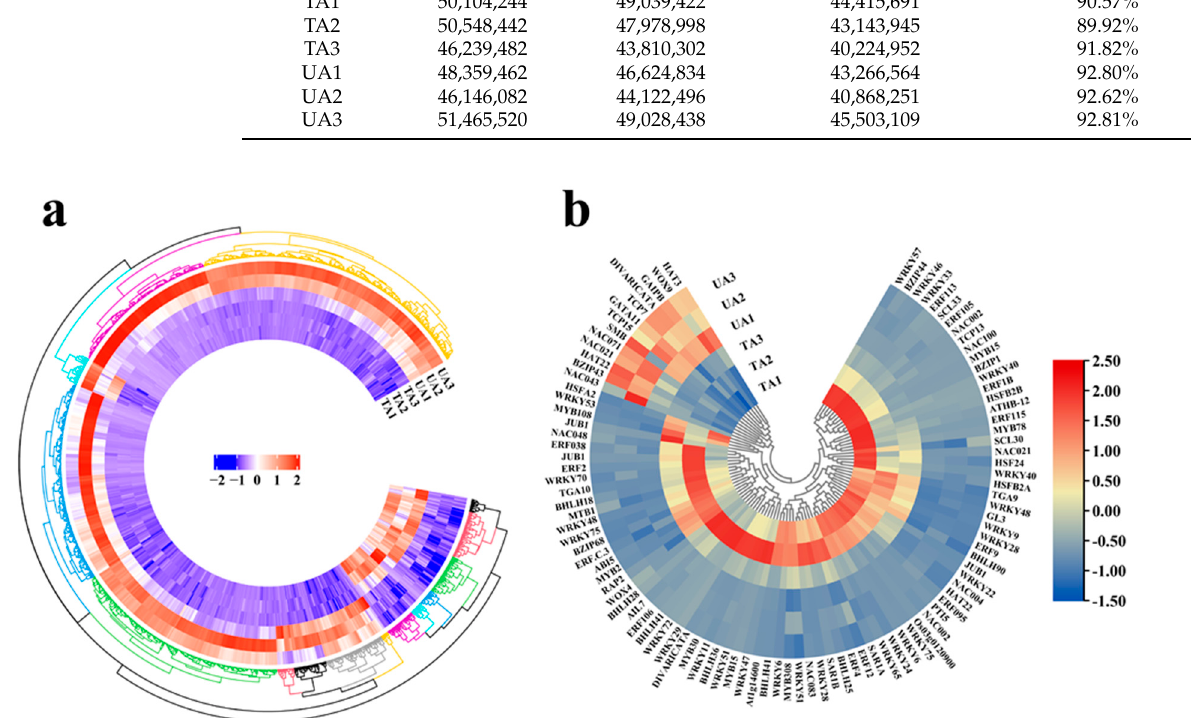
Figure 1. Expression profiles of mRNAs in A. sinensis . ( a ) Hierarchical clustering of all differentially expressed transcripts. ( b ) Hierarchical clustering of differentially expressed transcription factors.